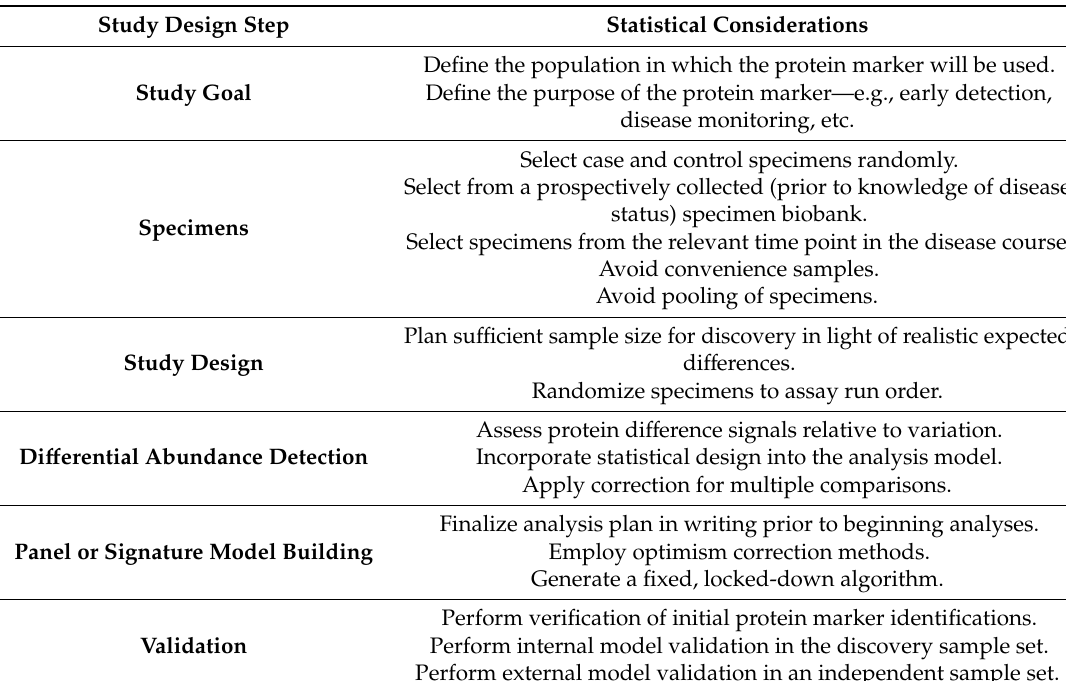
Table1. Experimentaldesignandstatisticalconsiderationsformaximizingthelikelihoodofreproducible biomarker discovery